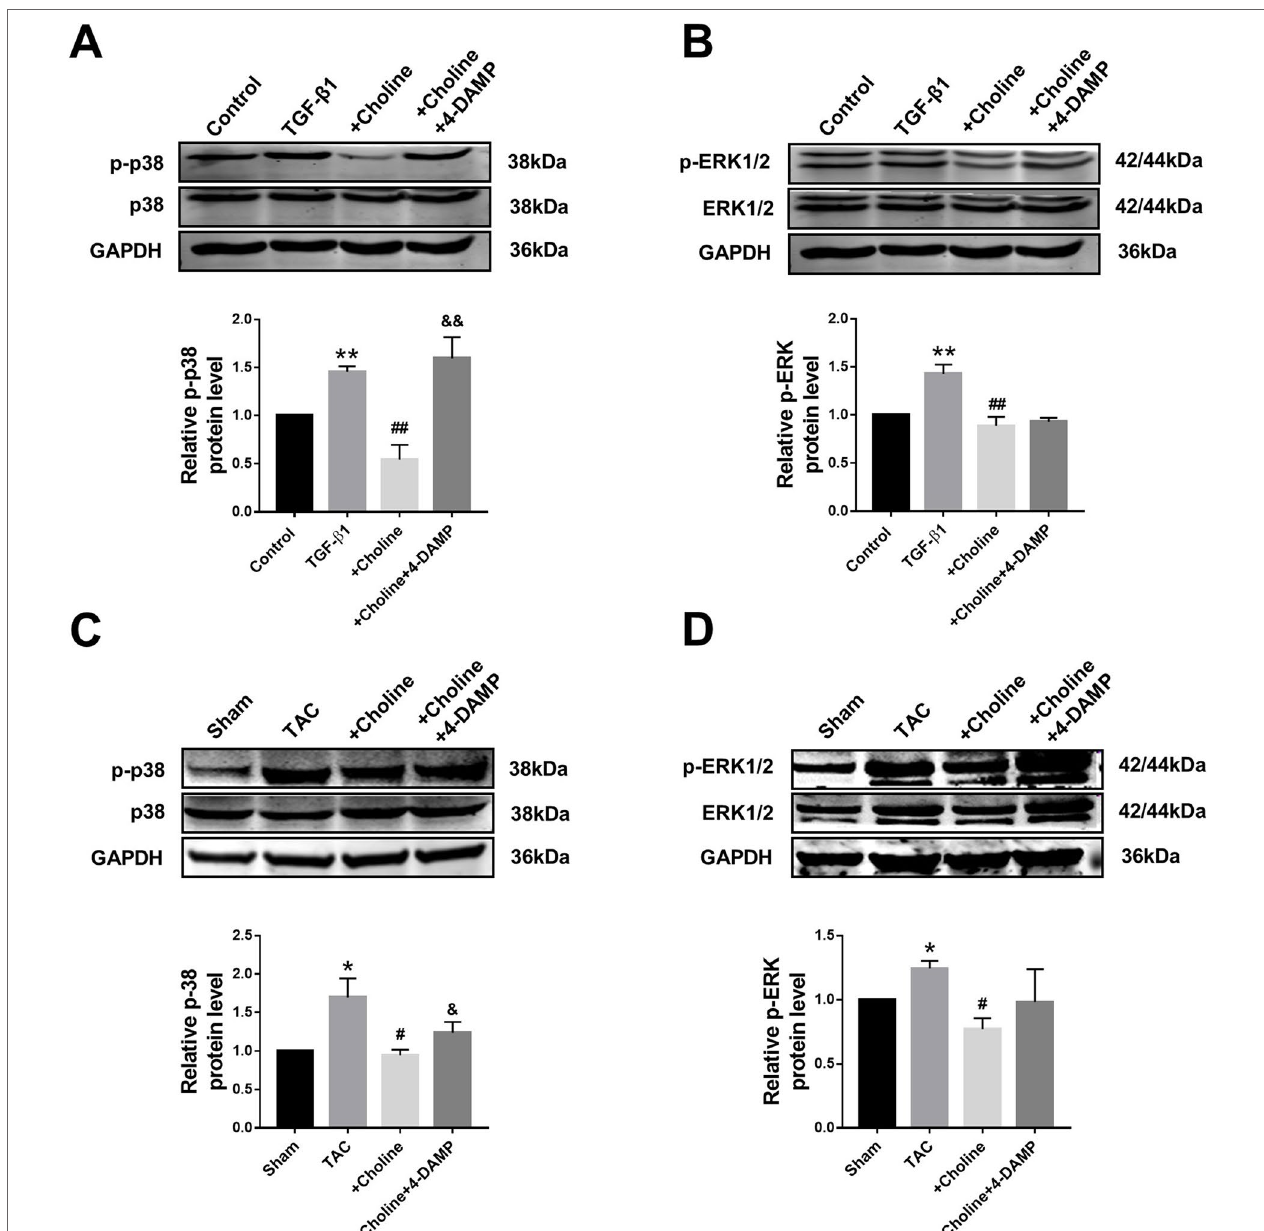
FIgURe 6 | Effect of choline and 4-diphenylacetoxy- N -methylpiperidine methiodide (4-DAMP) on protein levels of p38MAPK and ERK1/2. (A) Effect of choline and 4-DAMP on p-p38 protein level in transforming growth factor beta 1 (TGF-β1)-induced cardiac fibroblasts (CF). ** p < 0.01 vs. Ctrl, ## p < 0.01 vs. TGF-β1, && p < 0.01 vs. choline, n = 5. (B) Effect of choline and 4-DAMP on p-ERK1/2 protein level in TGF-β1-induced CF. ** p < 0.01 vs. Ctrl, ## p < 0.01 vs. TGF-β1, n = 6. (C) Effects of choline and 4-DAMP on the protein level of p-p38 in transverse aortic constriction (TAC) mice hearts. * p < 0.05 vs. sham, # p < 0.05 vs. TAC, & p < 0.05 vs. choline, n = 5. (D) Effects of choline and 4-DAMP on the protein level of p-ERK in TAC mice hearts. * p < 0.05 vs. sham, # P < 0.05 vs. TAC, n = 4.